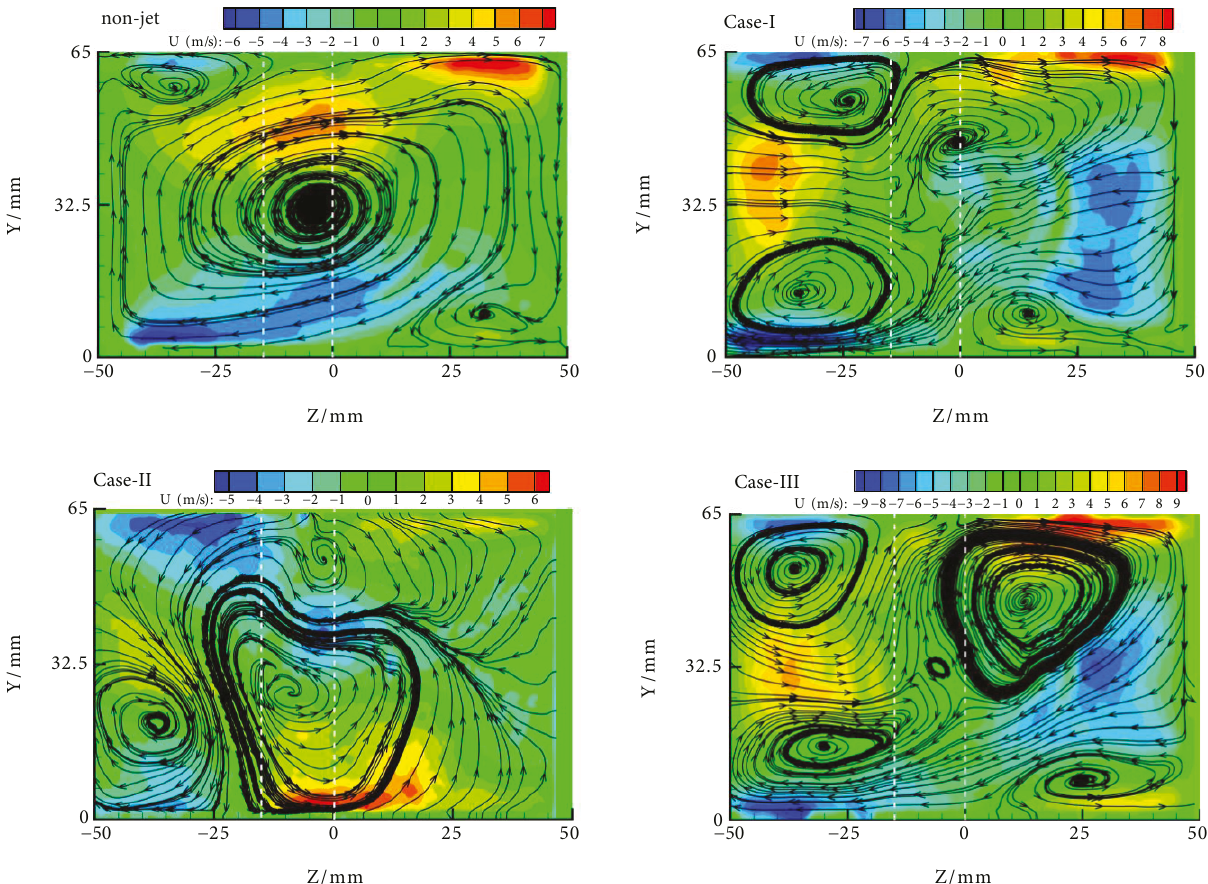
Figure 12: Axial velocity contours and streamline in the plane of X = 20mm